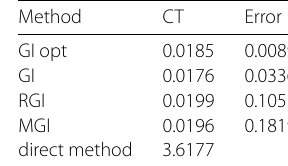
Figure 3 Relative errors for Example